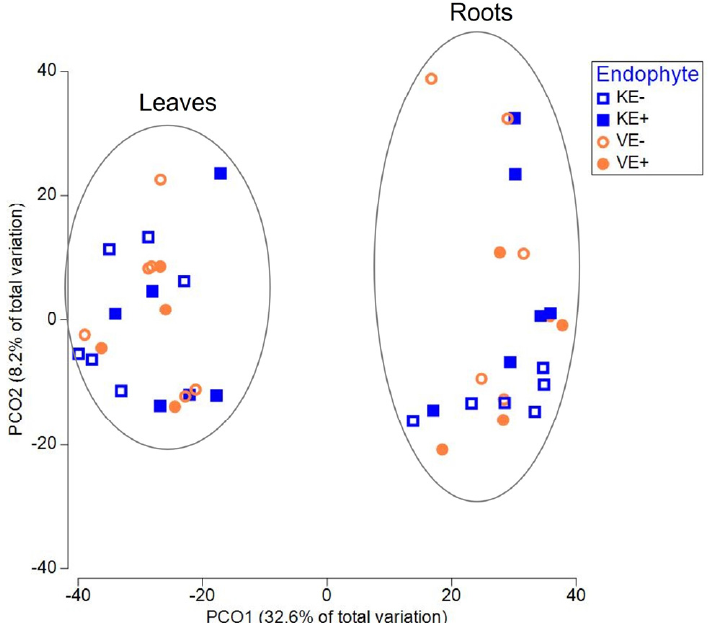
Figure 7. PCoA analysis of the bacterial communities in the leaves and roots of meadow fescue ( Festuca pratensis ) cultivars ‘Kasper’ and ‘Valtteri’. ‘Kasper’ Epichloë -free plants (KE-), ‘Kasper’ Epichloë -symbiotic plants (KE+), ‘Valtteri’ Epichloë -free plants (VE-), ‘Valtteri’ Epichloë -symbiotic plants (VE+).